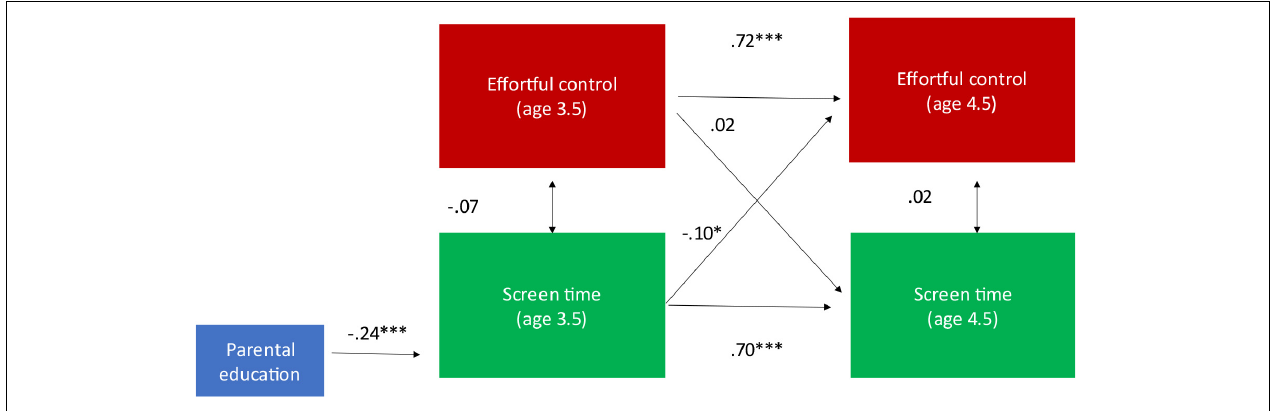
FIGURE 1 | Longitudinal cross-lagged associations between preschool screen media use and effortful control. * p ≤ 0.05 and *** p ≤ 0.001.